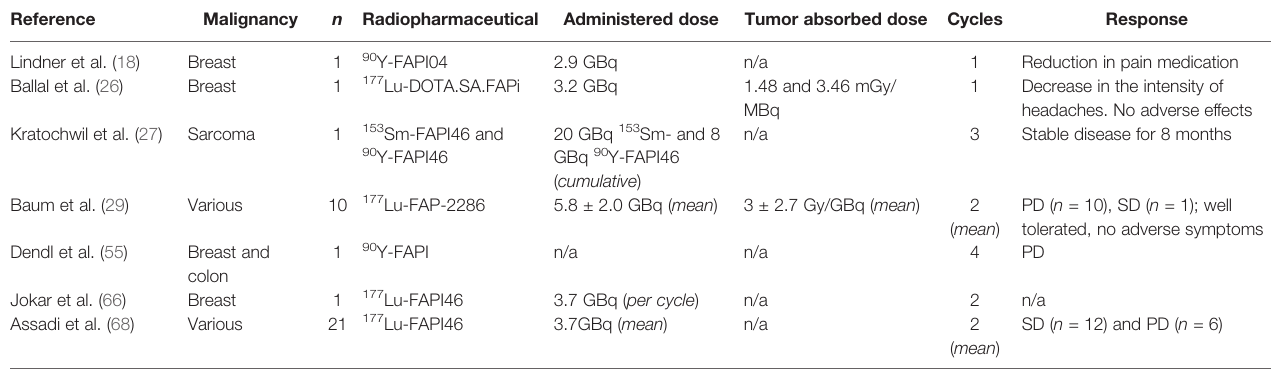
TABLE 2 | Summary of studies evaluating FAP-targeted radionuclide